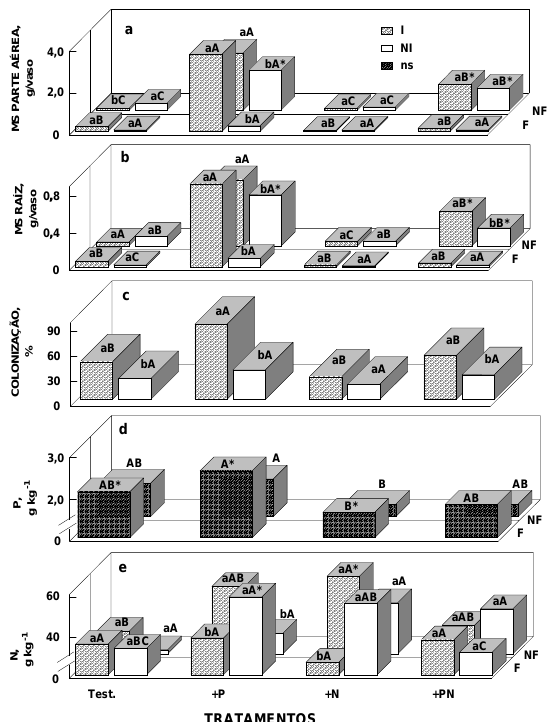
Figura 5. Parâmetros de crescimento, colonização micorrízica e teores de nutrientes na massa seca aérea do fedegoso em resposta à inoculação com Glomus etunicatum (I- inoculado; NI- não inoculado) em solo fumigado (F) ou não fumigado (NF) e adubado com nitrogênio (N), fósforo (P) e PN. As médias seguidas pelas mesmas letras (maiúsculas comparam adubação e minúsculas comparam inoculação) não diferem pelo teste de Tukey a 5%. * Efeito significativo pelo teste de Tukey a 5% para